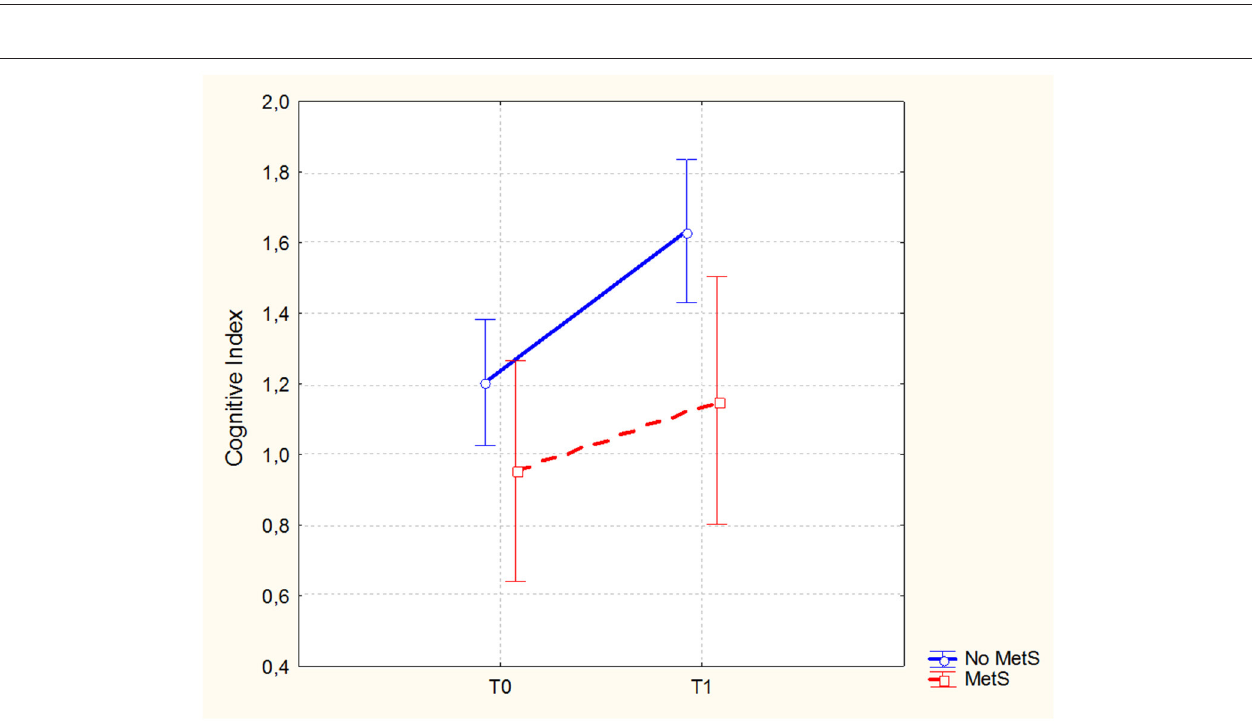
FIGURE 2 | Global cognitive performance (Brief Assessment of Cognition in Schizophrenia-BACS, Cognitive Index mean scores and 0.95 confidence intervals) from pre- to post-cognitive remediation therapy in patients stratified by metabolic syndrome.